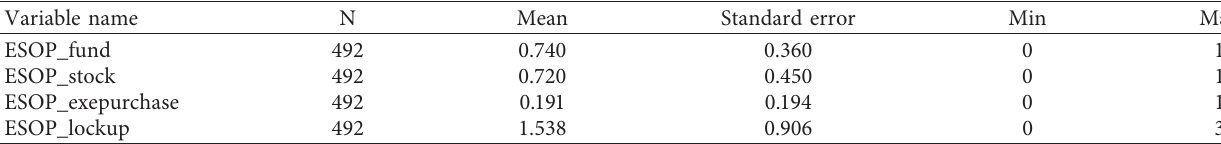
Table 3: Descriptive statistics for the contract elements of